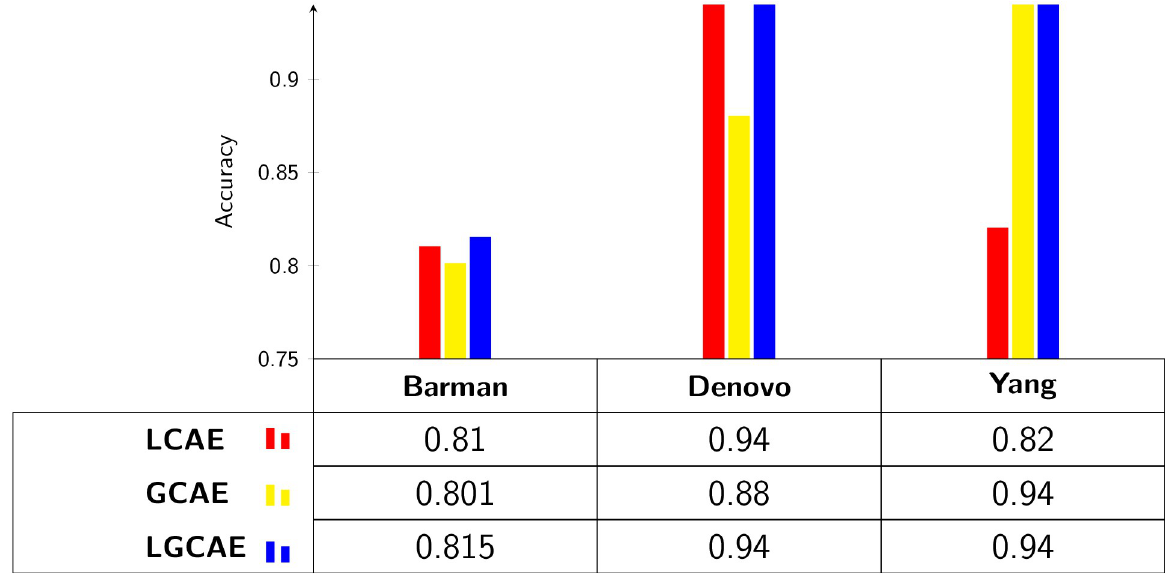
Fig 6. Performance comparison of local, global, and local-global residue context aware viral-host protein sequence representation learning schemes using deep forest model over 3 benchmark viral-host PPI prediction datasets.